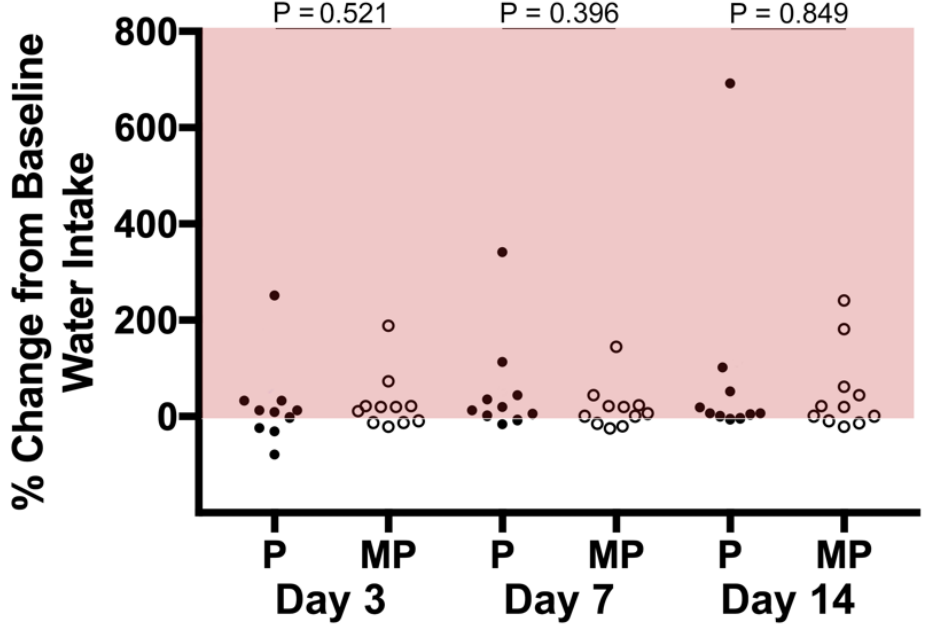
Figure 1. Percentage change from baseline water intake. The pink area indicates no change or increases in water consumption.